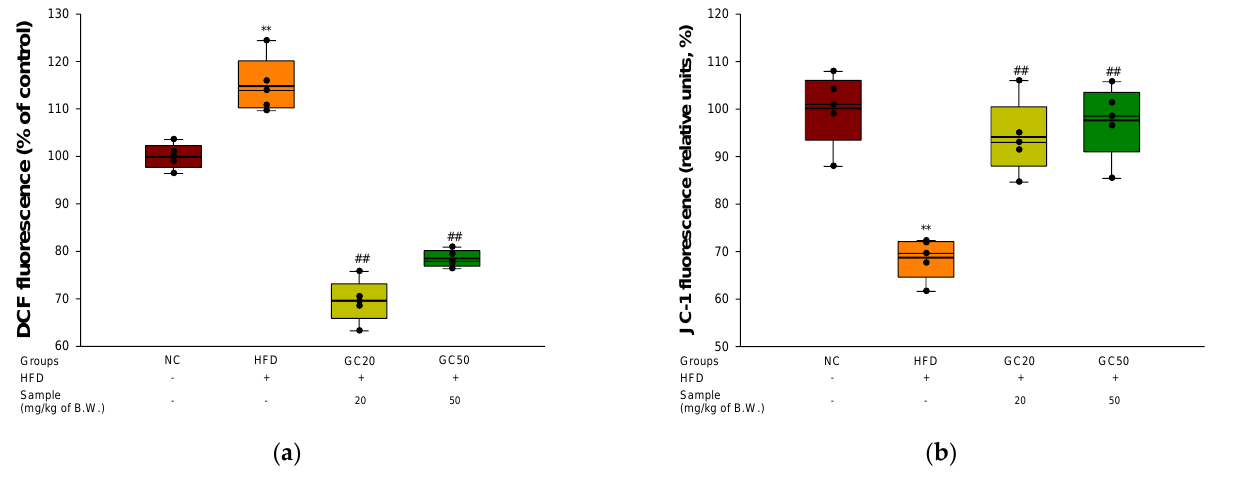
Figure 9. Protective effect of 80% ethanolic extract from Gimcheon 1ho (GC) cultivar walnut ( Juglans regia ) on mitochondrial dysfunction in HFD-induced mice: ( a ) cerebral ROS contents; ( b ) cerebral MMP levels Results shown are mean ± SD ( n = 5). Data are statistically represented with * = significantly different from the NC group, and # = significantly different from PM group; * and # p < 0.05, ** and ## p < 0.01. Bold line indicates mean.